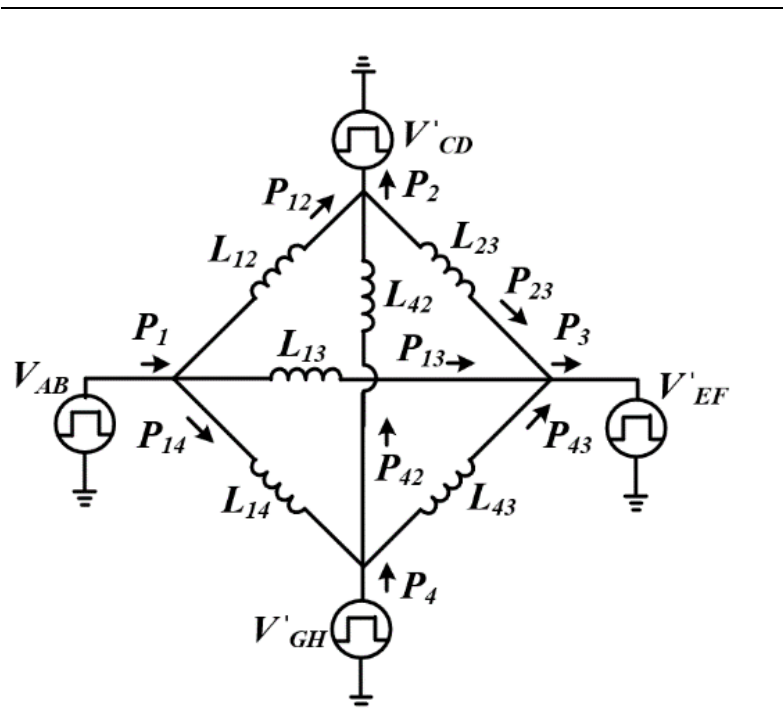
Figure 11. Equivalent model of the converter.